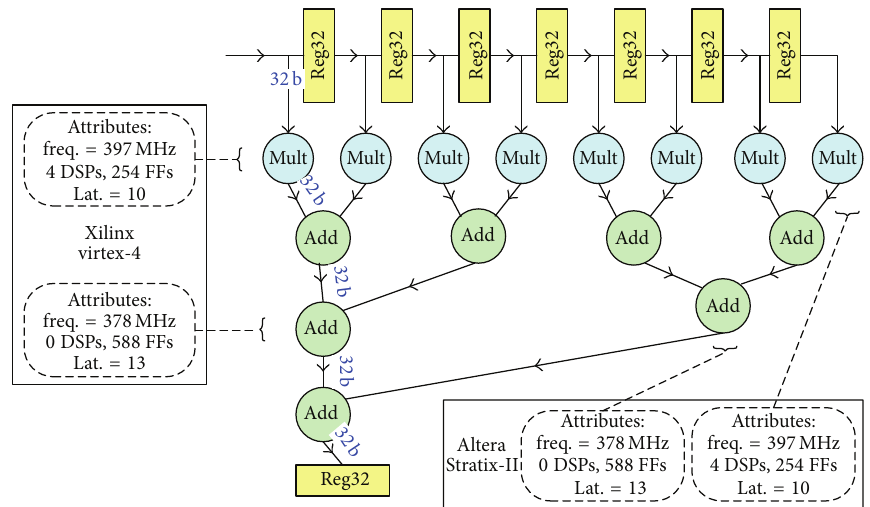
Figure 7: Core-level model of SPFP 8-tap FIR filter.